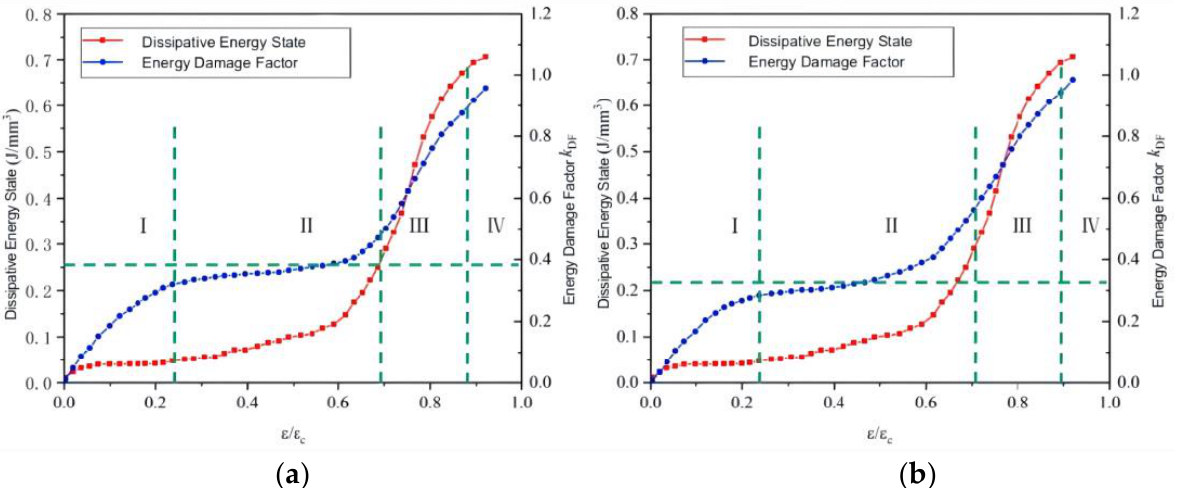
Figure 15. Evolution diagram of energy damage factor in coal specimen failure process. The green line is used to delineate the different stages through which the coal samples in the diagram have gone. ( a ) Dissipative energy stage and k DF of the coal sample S1. ( b ) Dissipative energy stage and k DF of the coal sample S2.